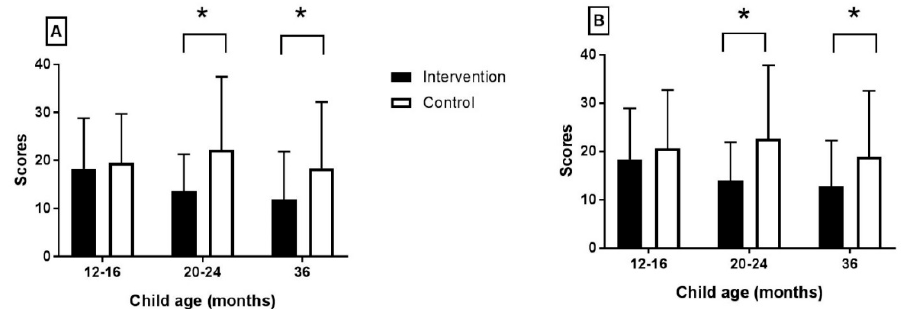
Figure 2. Maternal depression scores derived from the ( A ) BDI-II and ( B ) CES-D questionnaires. Values are means and SD. Asterisk denotes significant difference .